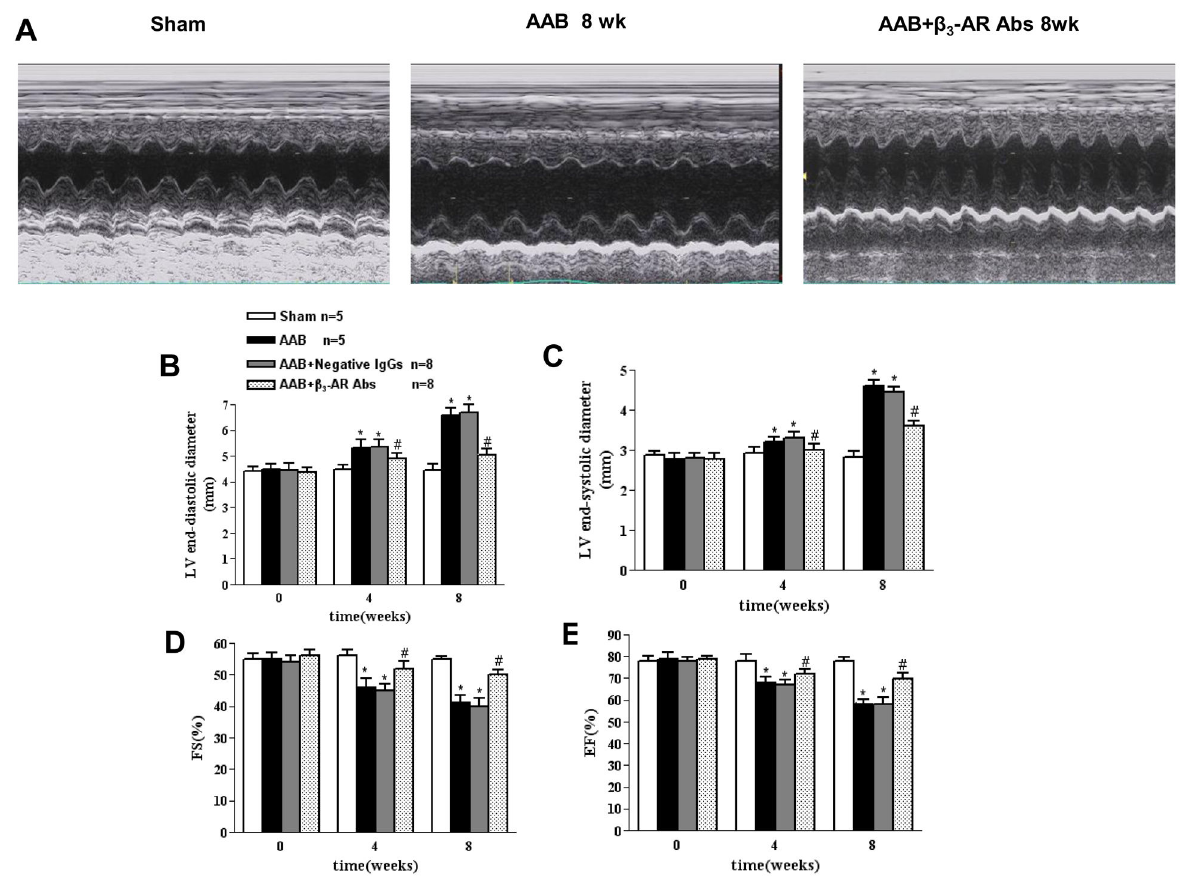
Figure 3. Effects of β -AR Abs on LV dilation and systolic function in AAB rats by echocardiography. A. M-mode 3 echocardiography images from Sham-operated (Sham), 8wk post-AAB, and 8wk post-AAB treated with β -AR Abs. B. C. β -AR Abs 3 3 prevented LV chamber dilation induced by AAB. D. E β -AR Abs ameliorated LV systolic dysfunction induced by AAB. 3 * P <0.05 vs . Sham-operated group, # P <0.05 vs . AAB group. Sham n=5, AAB n=5, AAB+β -AR Abs n=8, AAB+Negative IgGs n=8. 3 FS: fractional shortening, EF: ejection